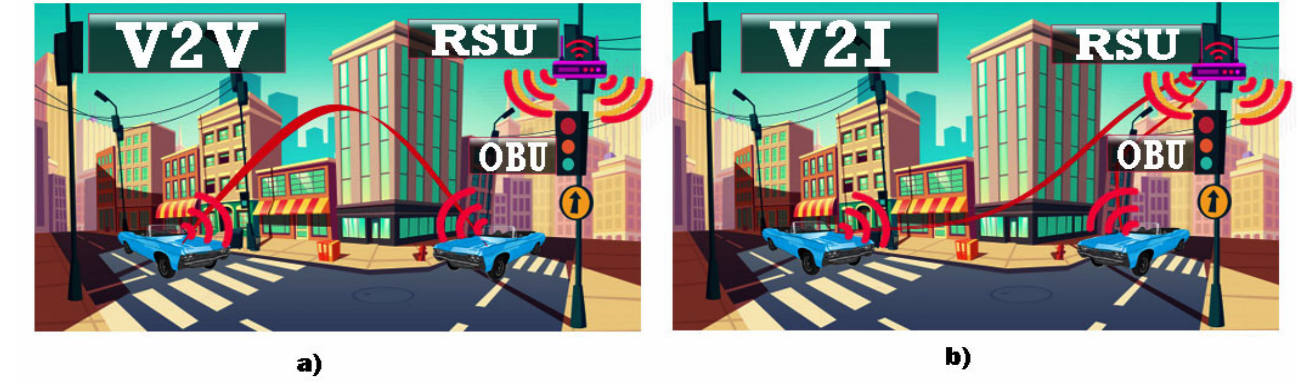
Figure 1. ( a ) Vehicle-to-vehicle communication with RSU-OBU; ( b ) Vehicle-to-infrastructure communication with RSU- OBU.